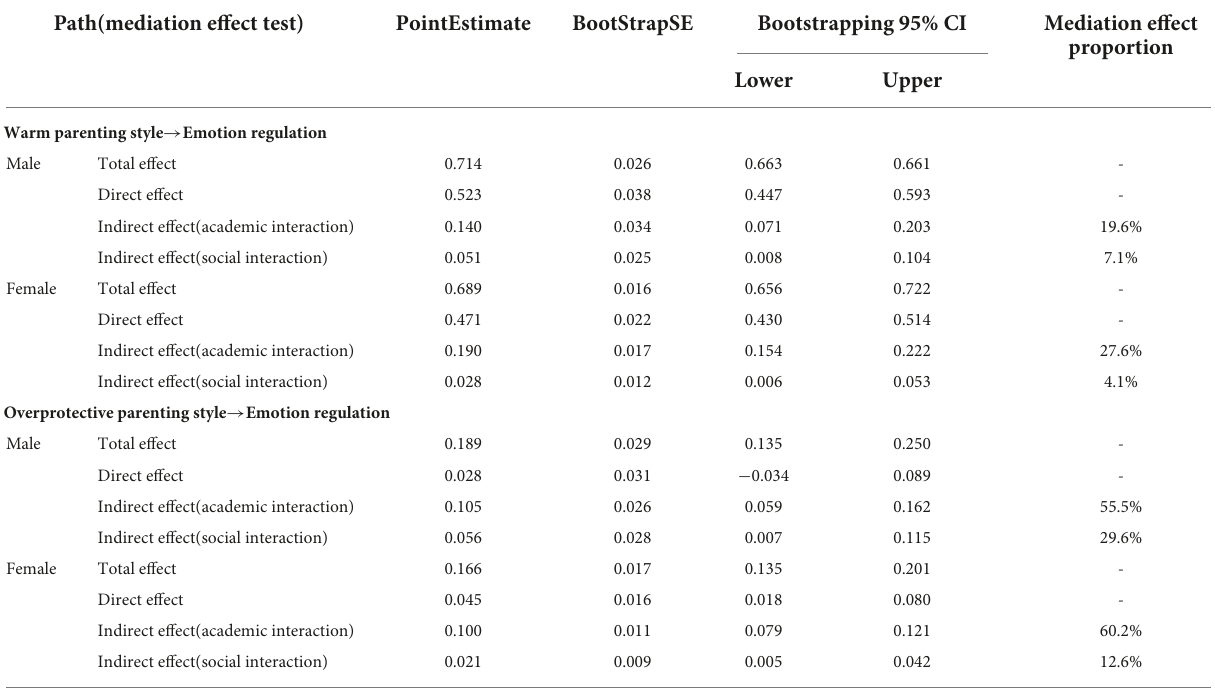
TABLE 6 Intermediary effects